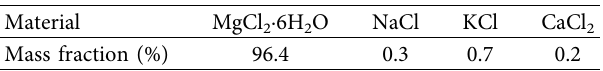
Table 3: Chemical compositions of magnesium chloride